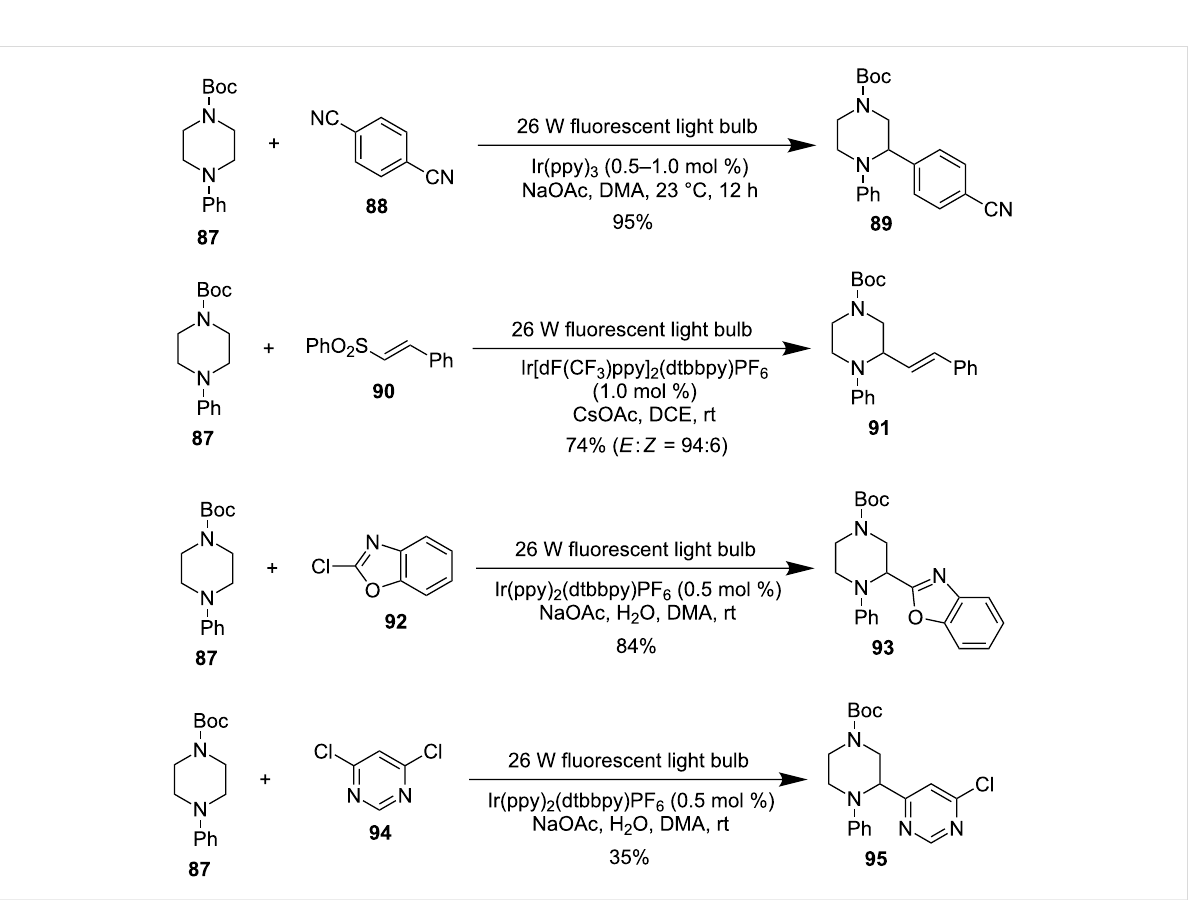
Figure 15: Photoredox catalysis for α -C–H functionalization of piperazines by MacMillan et al. in 2011 and 2014